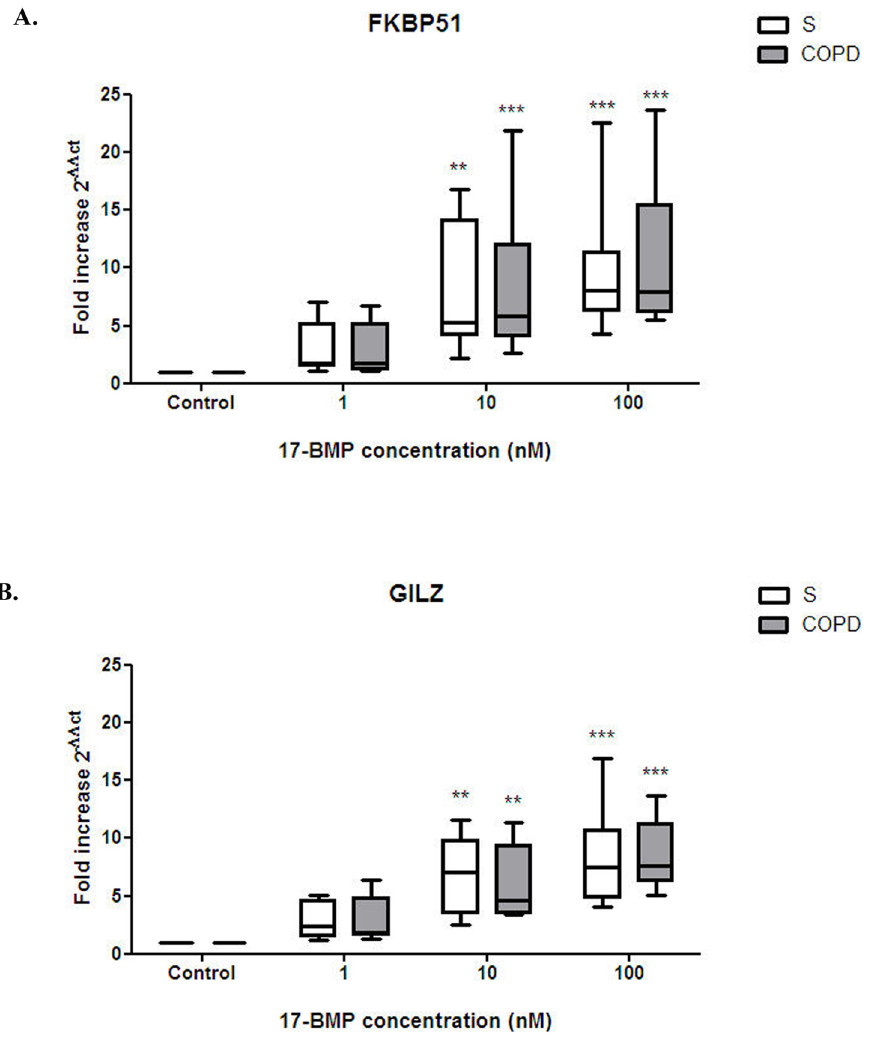
Figure 5. 17-BMP evokes upregulation of the GR dependent genes FKBP51 and GILZ. Lung macrophages from smoking controls (n=7) and COPD patients (n=7) were treated with 17-BMP (1–100 nM) or media alone for 24 h. RNA was extracted for PCR analysis of (A) FKBP51 and (B) GILZ expression. Data shown are median + range of fold increase of gene expression above controls. Box represents the 1 st and 3 rd quartile of the data set. Friedman Tests followed by Dunn’s multiple comparison tests were performed to determine upregulation compared to baseline: ** P , 0.01, *** P , 0.005. Two-tailed Mann-Whitney tests were performed between patient groups at each drug concentration; there was no difference between